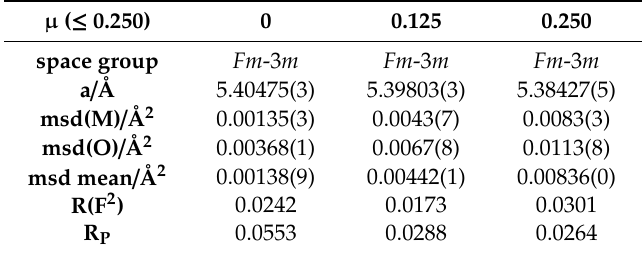
Table 1. Structural parameters returned by Rietveld refinements and Williamson–Hall analysis of synchrotron data at 90 K. Msd parameters are in Å 2 units.